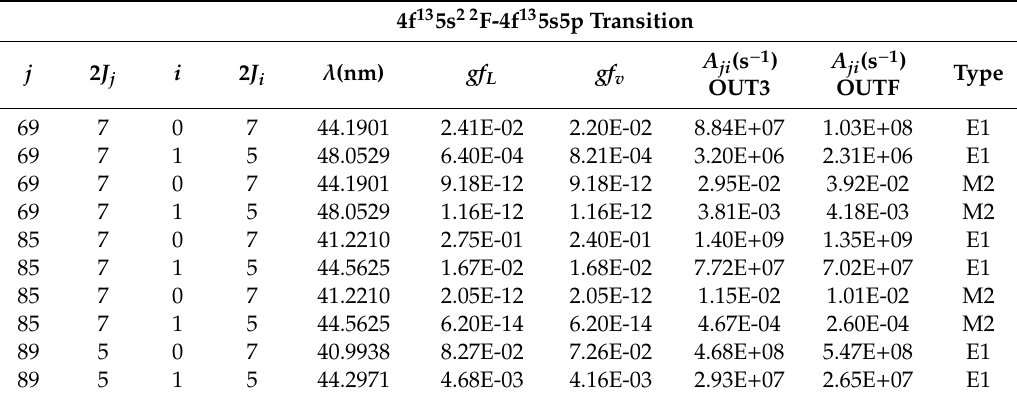
Table 12. Transition data for the 4f 13 5s 2 2 F-4f 13 5s5p and 4f 14 5s-4f 14 5p transitions in Pm-like W. Oscillator strength are given in both the length form ( gf L ) and velocity form ( gf v